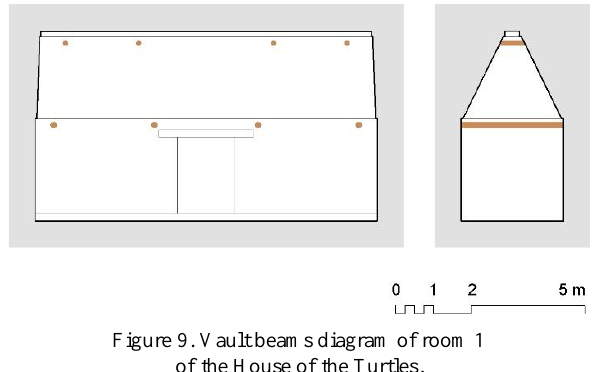
Figure 9. Vault beams diagram of room 1 of the House of the